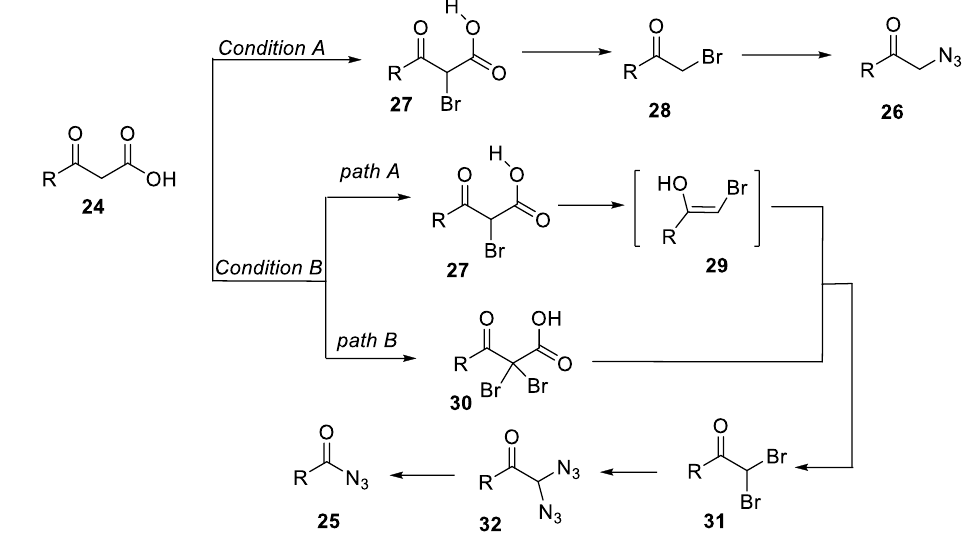
Figure 5. Possible pathways for the synthesis of acyl azides or α -azido ketones.